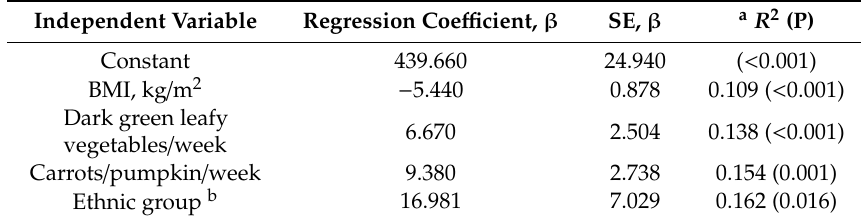
Table 4. Multiple regression analysis with carotenoid reflection score as the independent